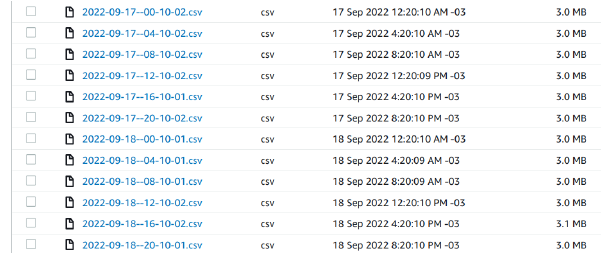
Figure A2. AWS S3 bucket with energy consumption records from smart